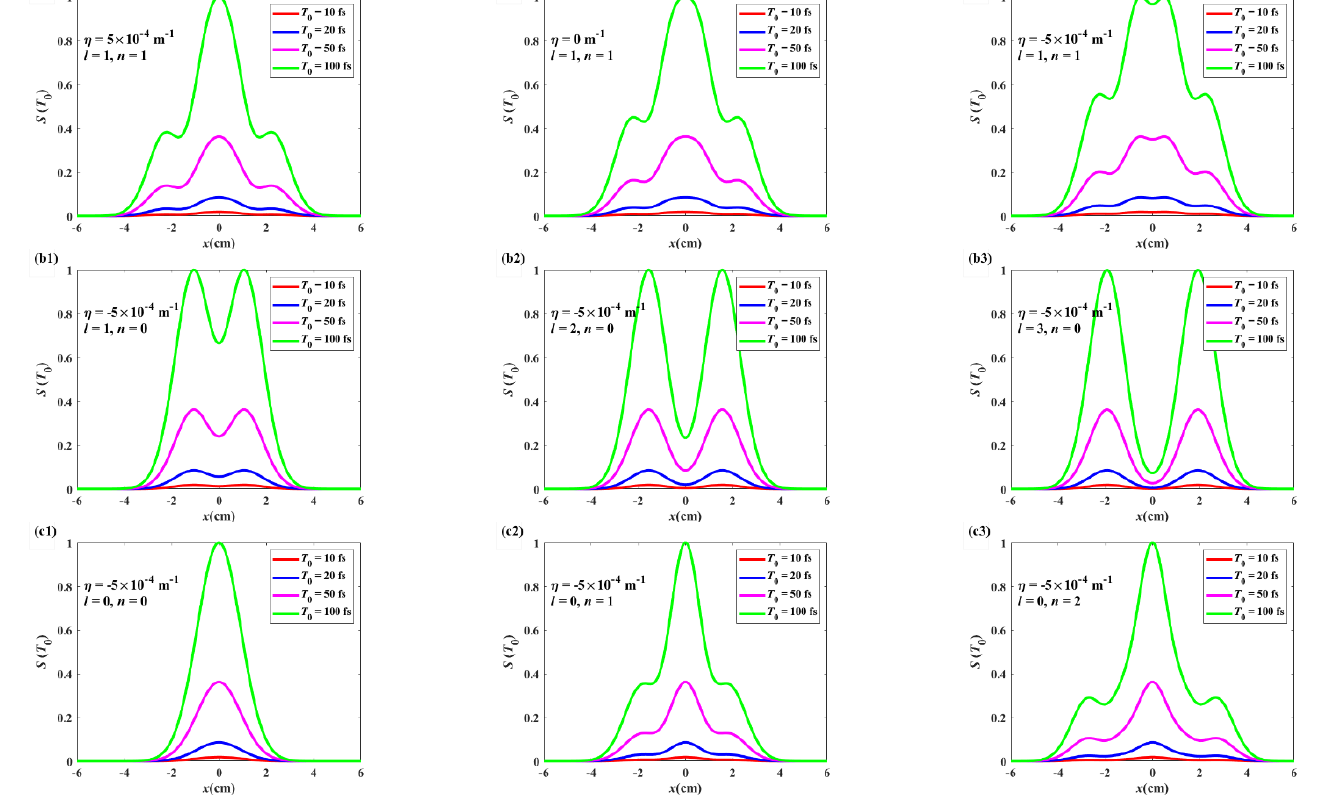
Figure 7. The relationship between the normalized spectral intensity with pulse duration of the PCTLGP beam propagating through the anisotropic turbulence for different ( a1 – a3 ) twisted factors, ( b1 – b3 ) topological charges, ( c1 – c3 ) mode orders ( ξ x = ξ y = 3, L = 0.3 km, C ̃ 2 n = 1 × 10 − 14 m 3 − α